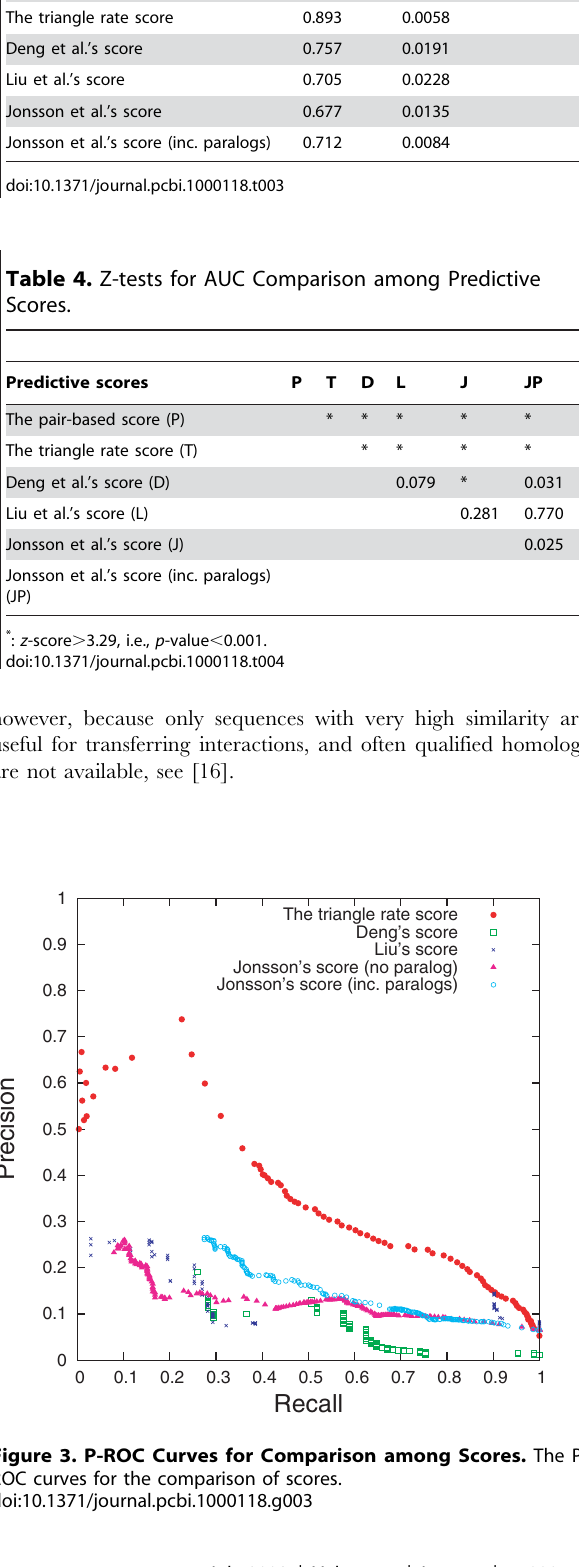
Predictive scores